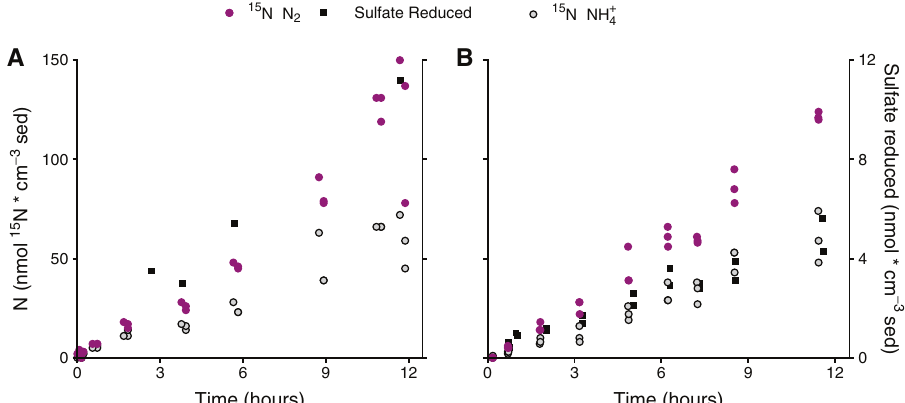
Fig. 3 Concurrent NO 3- and sulfate reduction in freshly collected surface sediments: 15 NH 4 + (light gray circles) and 15 N-N 2 production (purples circles) and the total sulfate reduced (black squares) are plotted for parallel nitrate amended incubations of surface sediment collected in October 2018 ( A ) and May 2019 ( B ). Each point represents a measurement from a separate incubation. Note the different scale bars.